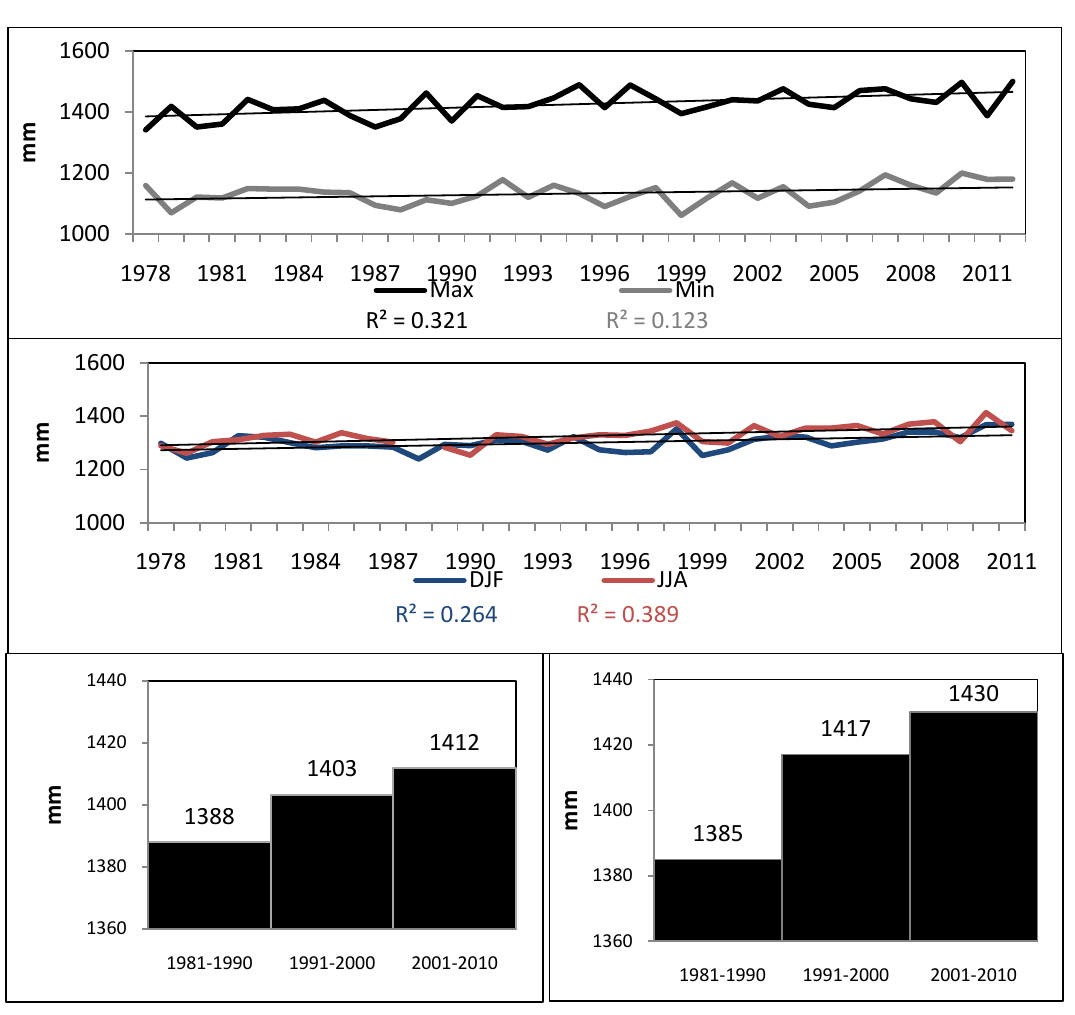
Figure 4. Upper Panel: Annual Maximum and Minimum Mean Sea Level. Middle: Seasonal Mean Sea Level (DJF-December, January and February; JJA-June, July and August). Lower Left: Maximum Annual Mean Sea Level trends. Lower Right: Mean Sea Level annual 90th percentile per decade.